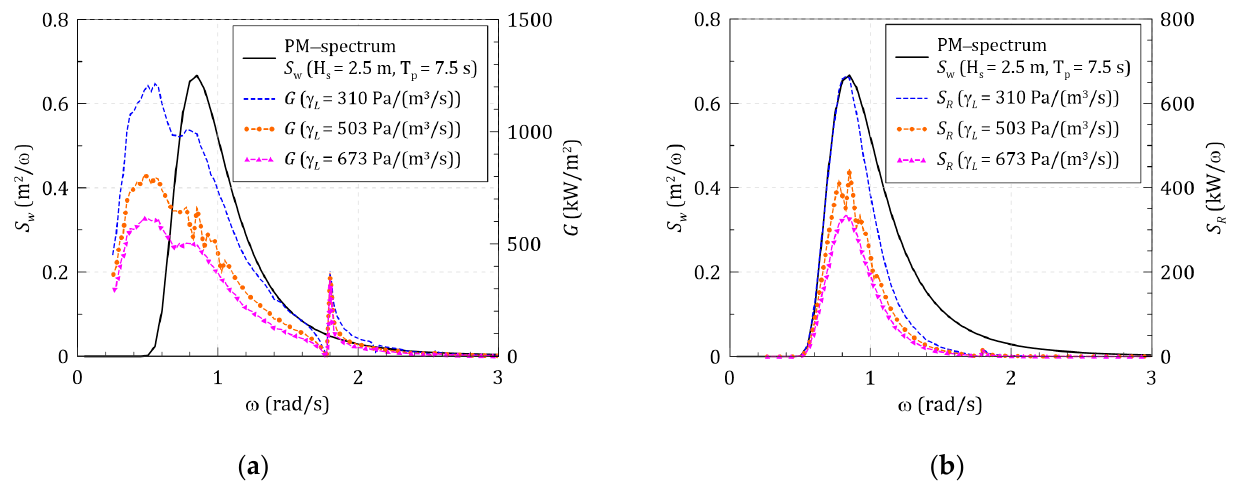
Figure 18. Application of response spectrum method for hydrodynamic energy conversion problem of the OWC chamber: ( a ) transfer function of pneumatic power and incident wave spectrum; ( b ) response spectrum of pneumatic power and incident wave spectrum.